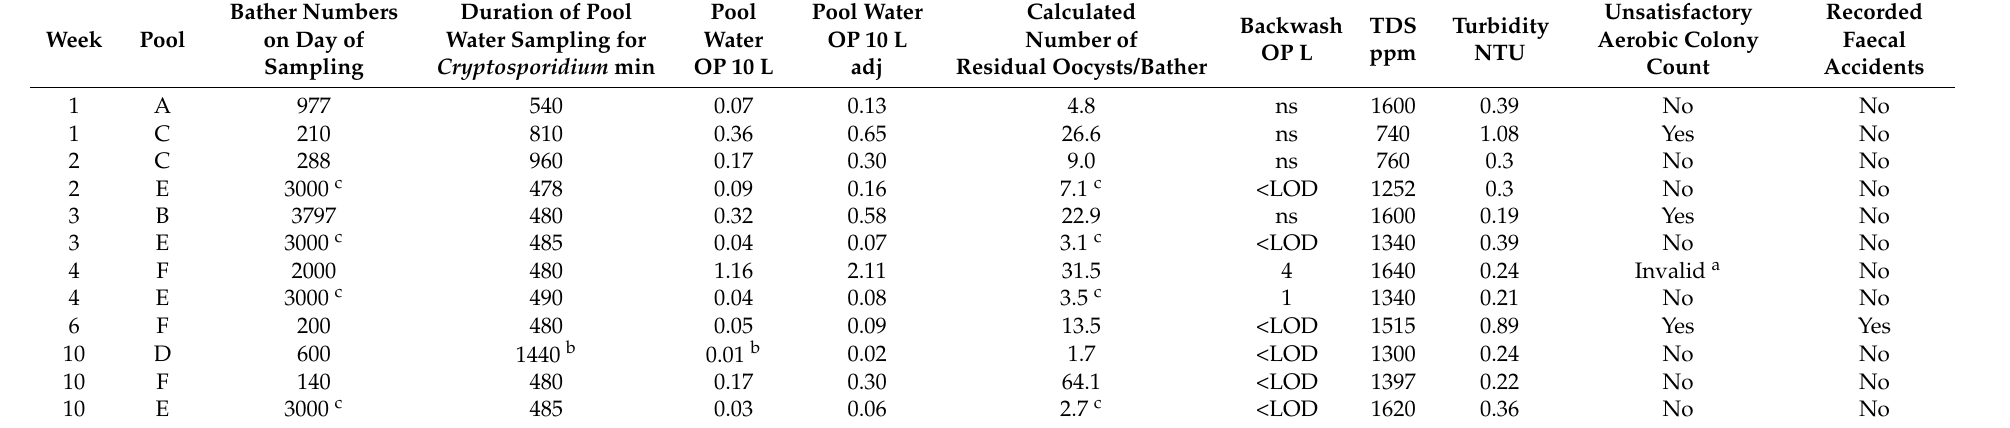
Table 4. Cryptosporidium oocyst detections and counts in pool water and backwash samples over 10 weeks from 8 August